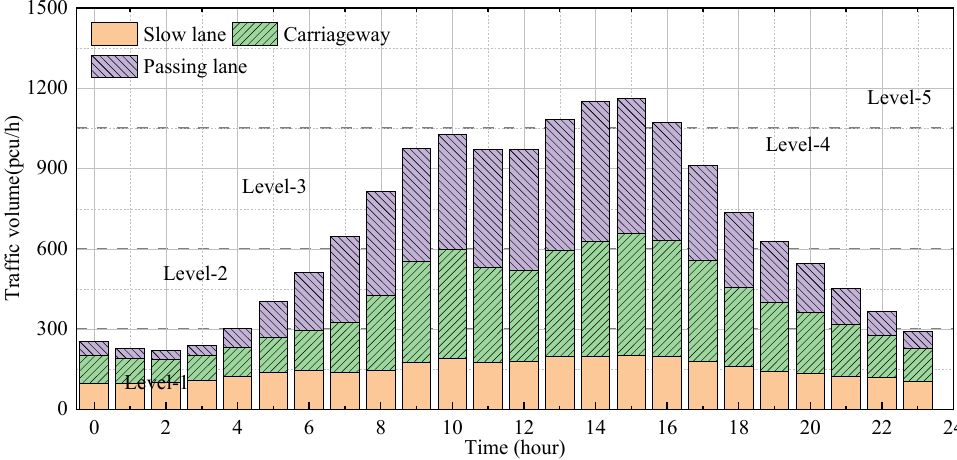
Figure 10. Average traffic volume from WIM data.